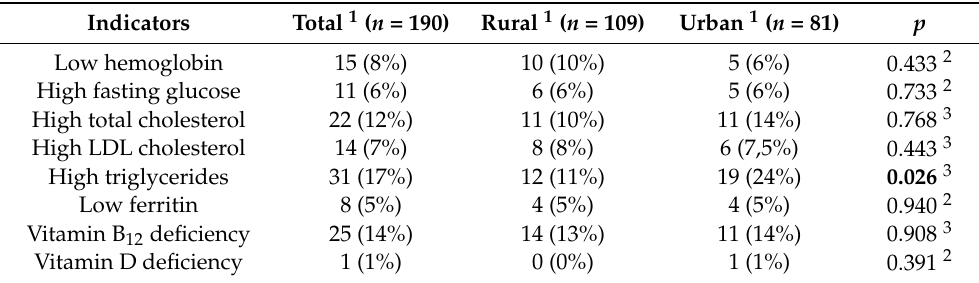
Table 2. Absolute and relative frequencies of laboratory inadequacies in school children in rural and urban